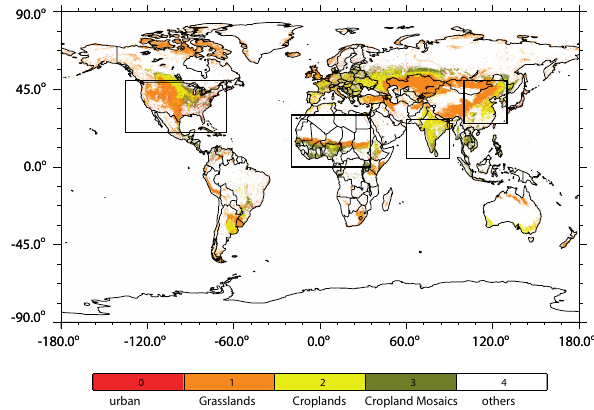
Figure 1. Global anthropogenic land cover (including urban, crop- land, and pastureland) distribution retrieved by combing MODIS and GRUMP